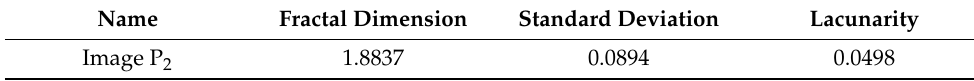
Table 2. Calculation of fractal characteristics of P 2